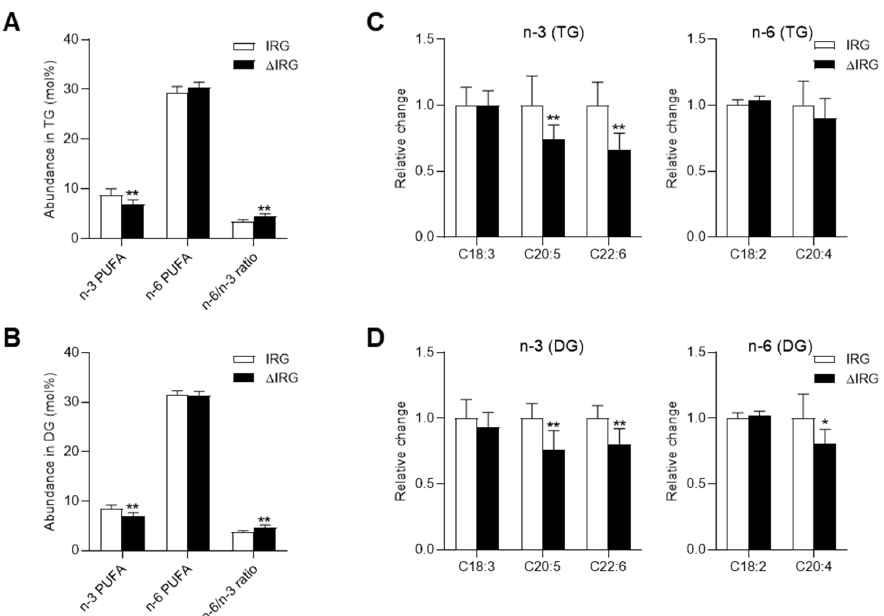
Figure 4. Polyunsaturated fatty acid composition in di- and triacylglycerols. Overall proportion of n-3 and n-6 PUFAs in the ( A ) triacylglycerols (TG) and ( B ) diacylgylcerols (DG) lipid classes in ∆ IRG mice in comparison to IRG mice. Relative changes of specific n-3 and n-6 PUFAs in the ( C ) TG and ( D ) DG lipid classes of ∆ IRG mice. Data are shown as means ± SD and analyzed by unpaired t -test with Welch’s correction. * p < 0.05; ** p < 0.01; IRG, n = 7; ∆ IRG, n =